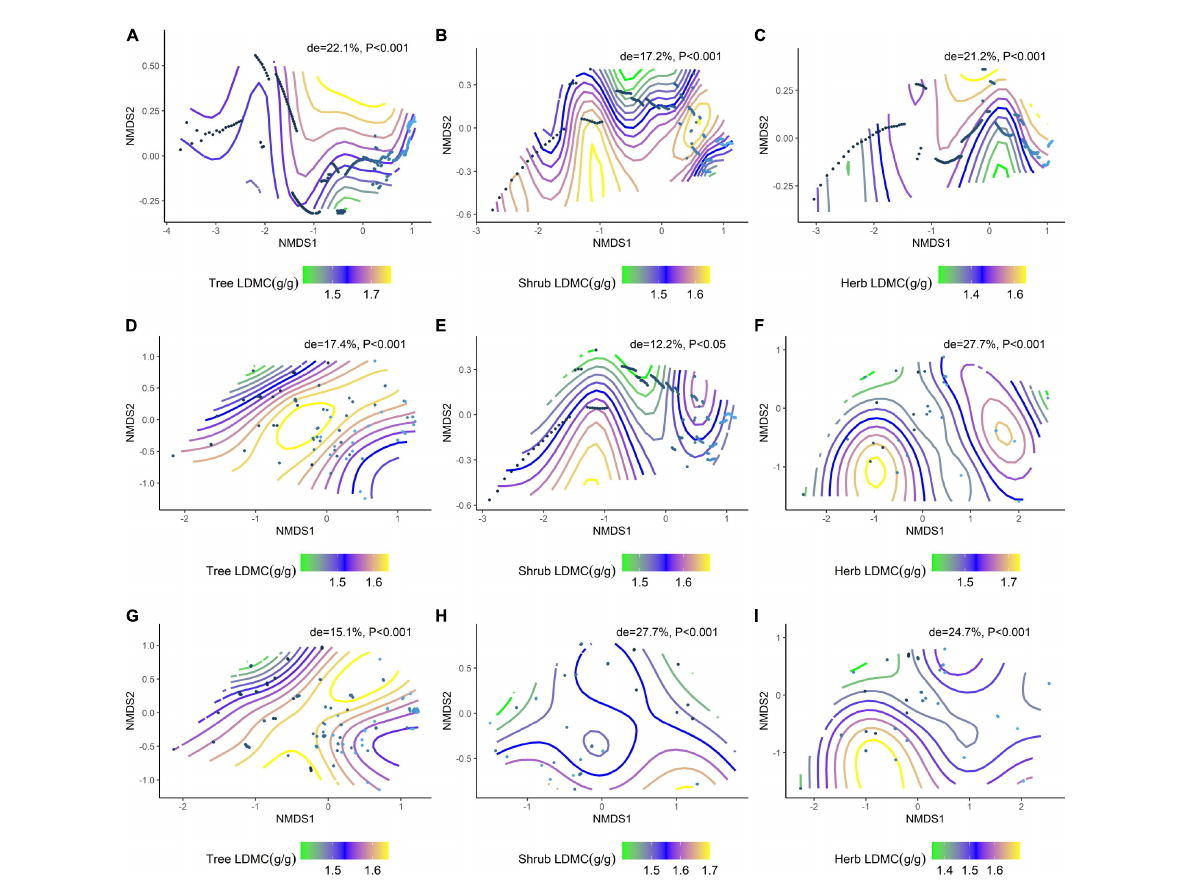
FIGURE7 NMDS ranking of climatic and soil factors with different life forms of LDMC. (A) NMDS ranking of soil factors with tree LDMC; (B) NMDS ranking of soil factors with shrub LDMC; (C) NMDS ranking of soil factors with herb LDMC; (D) NMDS ranking of climatic factors with tree LDMC; (E) NMDS ranking of climatic factors with shrub LDMC; (F) NMDS ranking of climate factors and herb LDMC; (G) NMDS ranking of the sum of soil factors and climate factors and tree LDMC; (H) NMDS ranking of the sum of soil factors and climate factors and shrub LDMC; (I) NMDS ranking of the sum of soil factors and climate factors and herb LDMC. Trait stacking indicates that abiotic factors, indicated by points on the NMD, are associated with higher or lower trait values, consistent with a colored trait gradient. Note that if the relationship between LDMC and abiotic factors is linear, the gradient splines will be parallel. Non-linear relationships between LDMC and abiotic factors are represented by curve